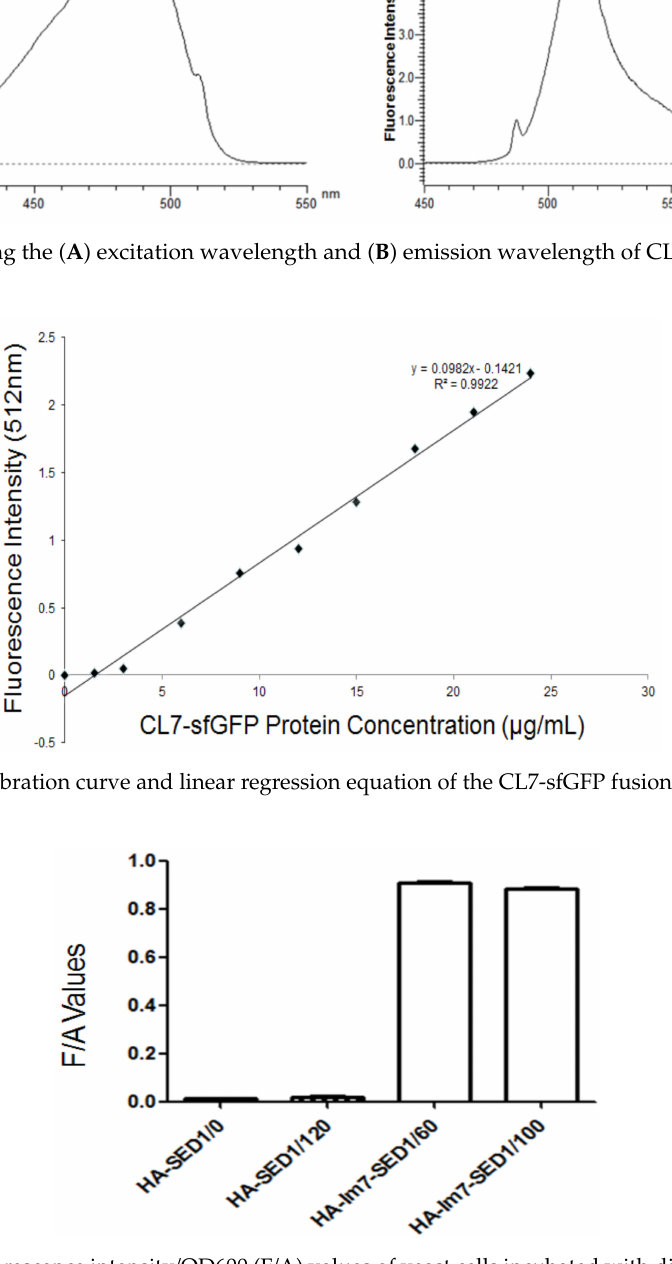
Figure 9. The fluorescence intensity / OD600 (F / A) values of yeast cells incubated with di ff erent amounts ( µ g) of